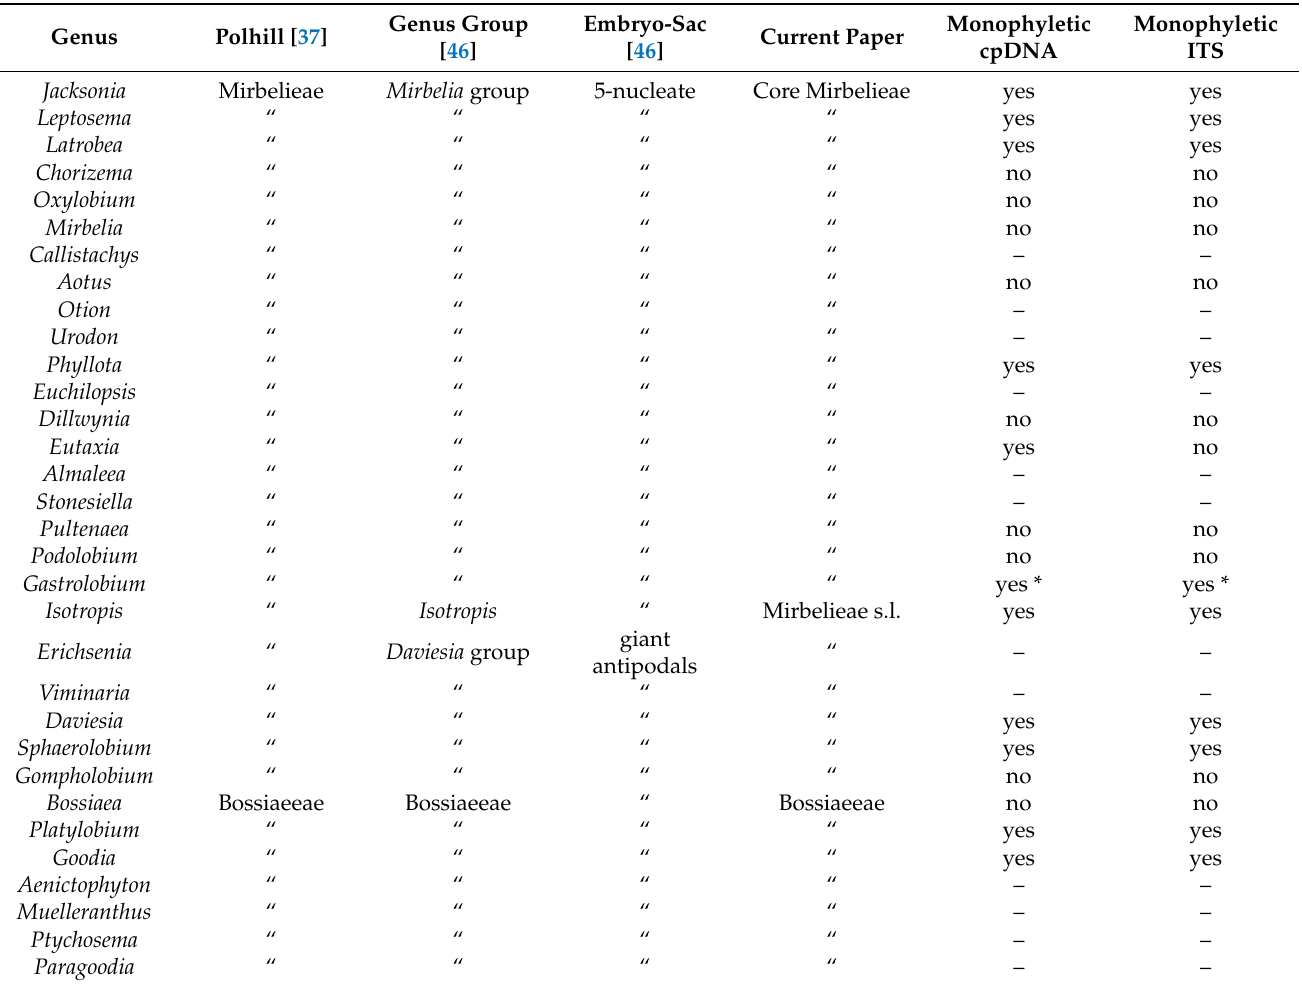
Table 1. Genera of Mirbelieae s.l. (column 1); previously published suprageneric classifications (columns 2 and 3); embryo- sac groups (column 4); usage in the present review; columns 5 and 6 indicate whether genera are monophyletic (yes/no/–) in published phylogenies with separate cpDNA and ITS trees